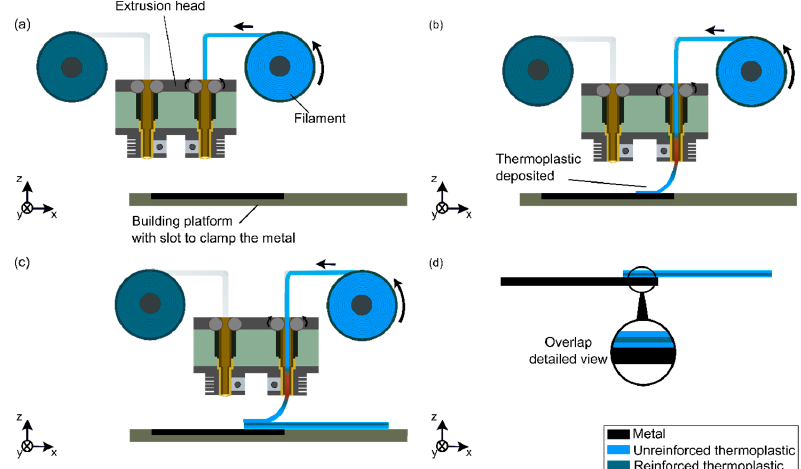
Figure 1. Schematic representation of the AddJoining process for layered metal–polymer composite hybrid structures: ( a ) initial setup, ( b ) deposition of the first polymer layer on the metal substrate, ( c ) deposition of the subsequent polymer layers, ( d ) final layered metal ‐ polymer hybrid structure. Reproduced from Reference [14].